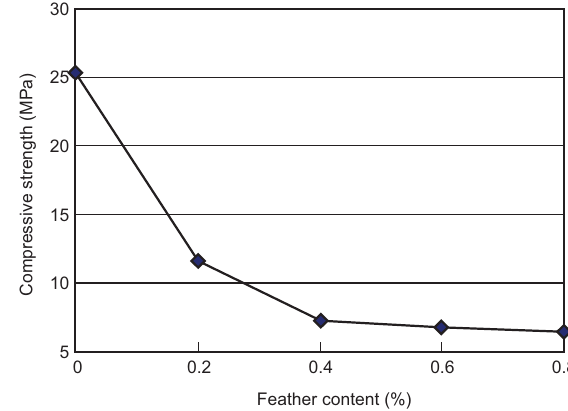
Figure 5 Porosity of hardened mortar cubes as a function of feather fiber content.